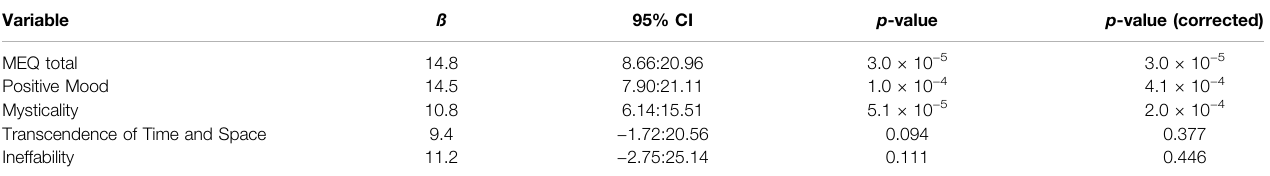
TABLE 2 | Results from the Latent Variable Model analyses for Mystical Experience Questionnaire (MEQ) total score and subsequent subscale analyses.